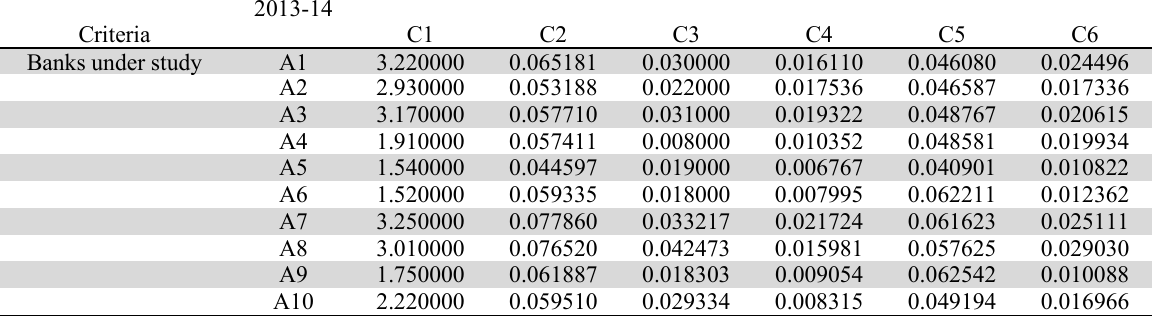
Descriptive Statistics (Fy 2013-14)